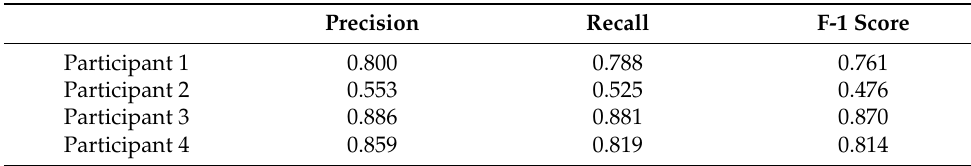
Figure 11. Four cases of user-independent validation using different features and models. Table 4. The precision, recall, and F-1 score of Case